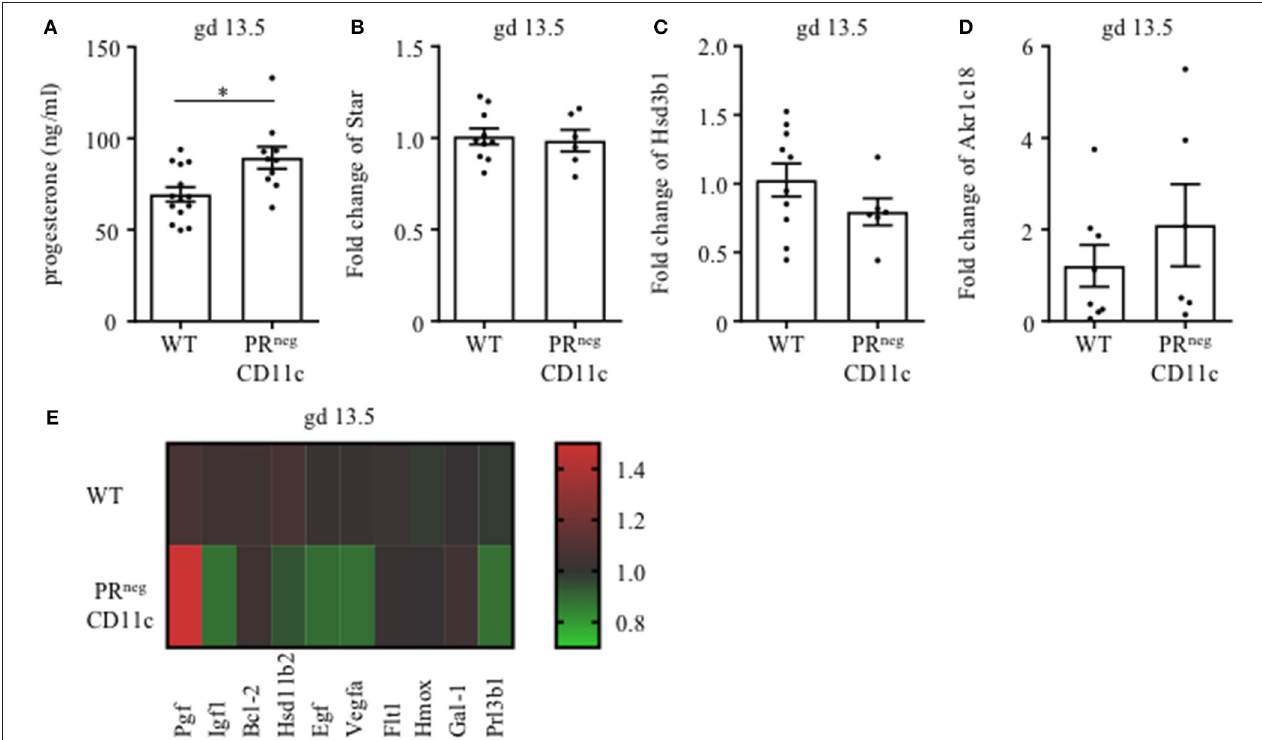
FIGURE 5 | Selective knockout of the progesterone receptor (PR) on CD11c + dendritic cells affects gene expression analysis of ovarian and placental tissue: (A) Plasma progesterone levels of WT and PR neg CD11c female mice on gd 13.5 as analyzed by ELISA. (B–D) Ovarian expression of steroidogenic acute regulatory protein (Star), 3 β -hydroxysteroid dehydrogenase (Hsd3b1), and 20 α HSD (Akr1c18) was assessed by qPCR from tissue harvested on gd 13.5. The fold change over WT control expression was calculated using beta-actin (Actb) and ubiquitin C (Ubc) as endogenous control and employing the 11 Ct method. (E) Heatmap summarizing the placental expression of placental growth factor (Plgf), insulin like growth factor 1 ( Igf1), B cell leukemia/lymphoma 2 (Bcl2), hydroxysteroid 11-beta dehydrogenase (Hsd11b2), epidermal growth factor (Egf), vascular endothelial growth factor A (Vegfa), soluble FMS-like tyrosine kinase 1 (sFlt1), heme oxygenase 1 (Hmox1), Galectin-1 (Gal-1), and placental lactogen II (Prl3b1) calculated by qPCR from gd 13.5 placentas. The fold change over WT control expression was calculated using RNA polymerase II subunit A (Polr2a) and Ubc as endogenous control and employing the 11 Ct method. Bars represent mean ± SEM. * p ≤